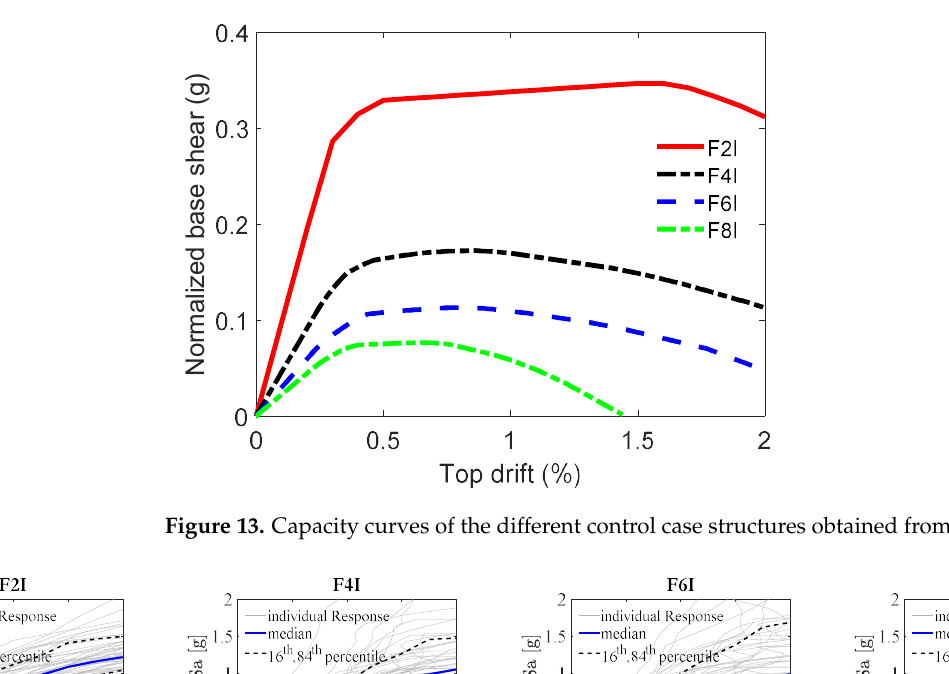
Figure 13. Capacity curves of the different control case structures obtained from pushover analyses.